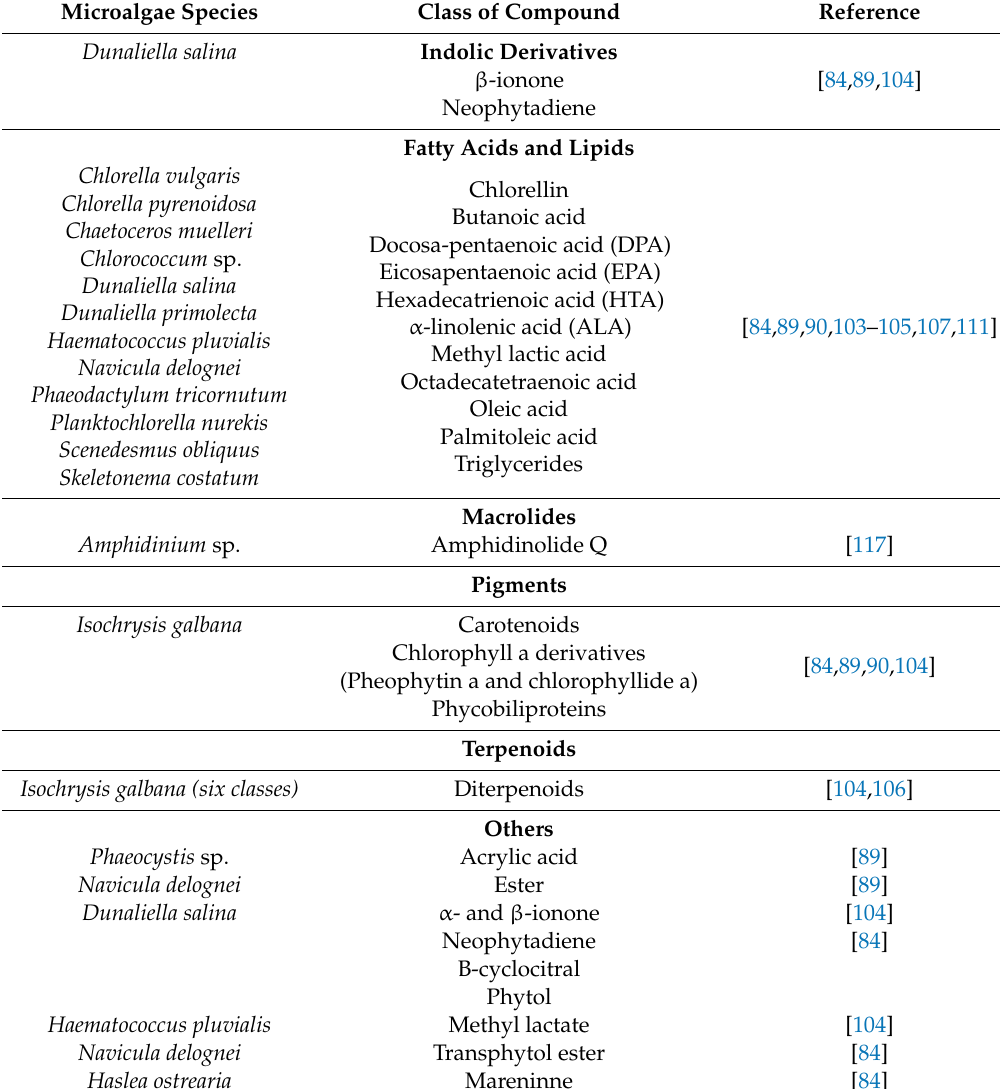
Table 2. Antibacterial compounds from